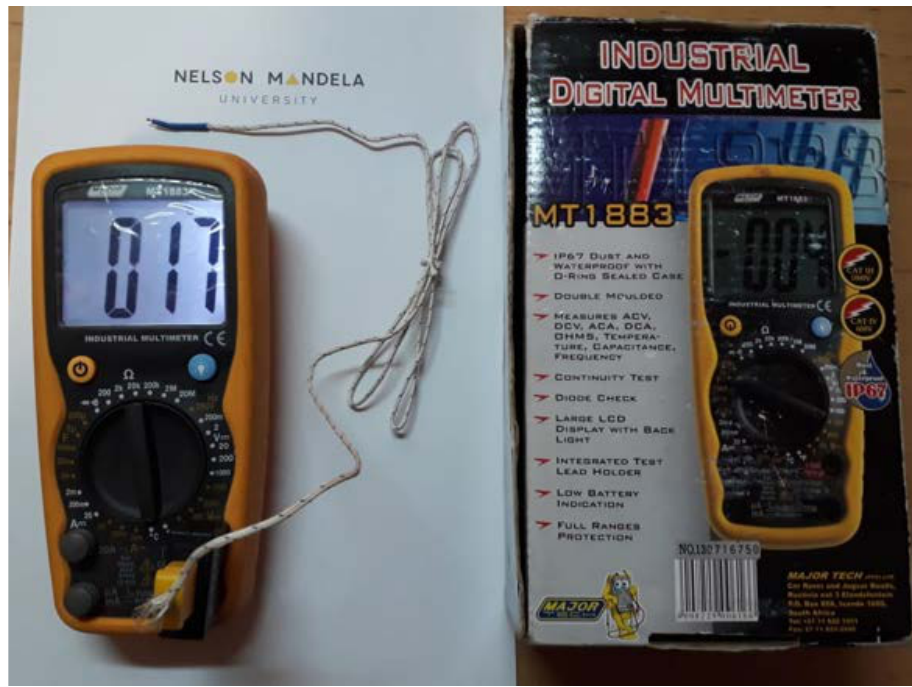
Figure 4: Thermocouple sensor